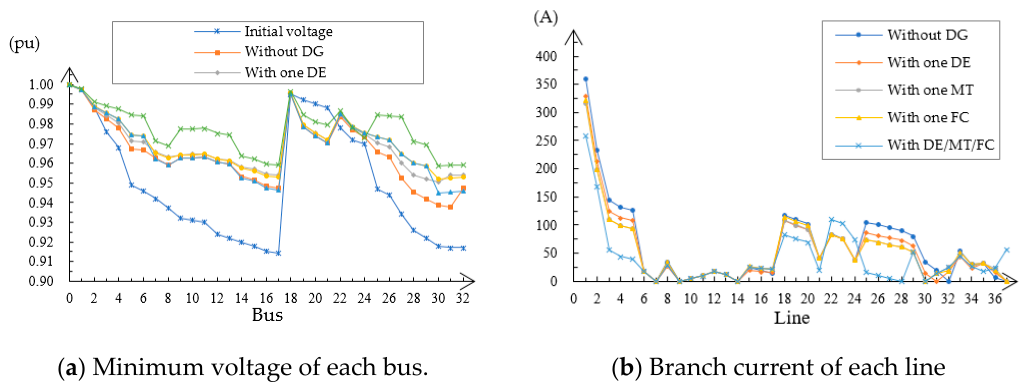
Figure 4. Effect of DG deployment on bus voltage and line current of system reconfiguration. Figure 4. E ff ect of DG deployment on bus voltage and line current of system reconfiguration.